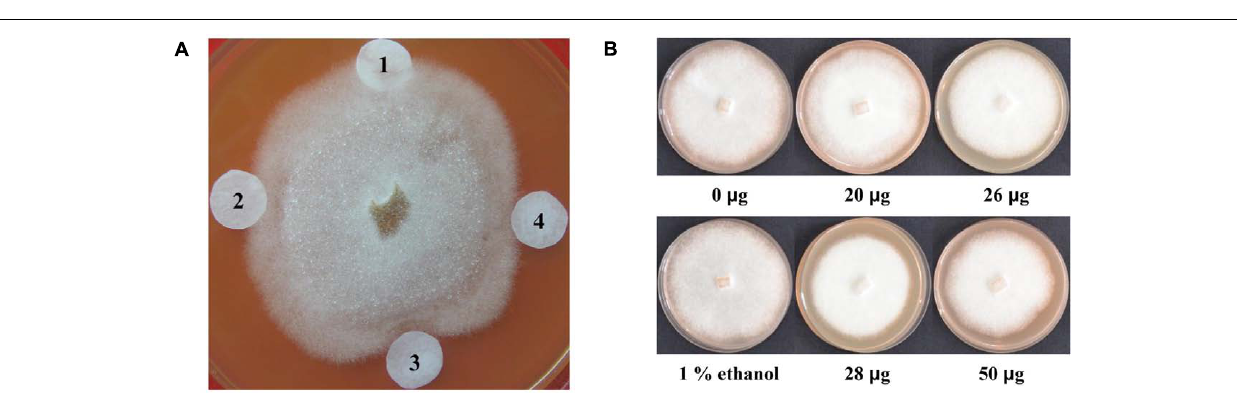
FIGURE 8 | Antimicrobial activity of lignan extracts. (A) Inhibition of P. sojae race 1 growth by lignan extracts. (1) Ethanol buffer; (2) lignan extracts (20 µ g) from a non-transgenic control plant; (3) lignan extracts (28 µ g) from the T5-19 transgenic plant line; (4) lignan extracts (26 µ g) from the T5-2 transgenic plant line. (B) Growth inhibition assay of P. sojae race 1 after 7 days of exposure of hyphal plugs to varying concentrations of lignan extracts. The experiment was performed three